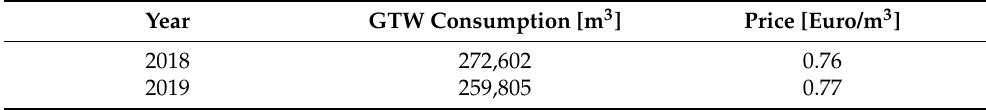
Table 2. HSGWPE geothermal water input.